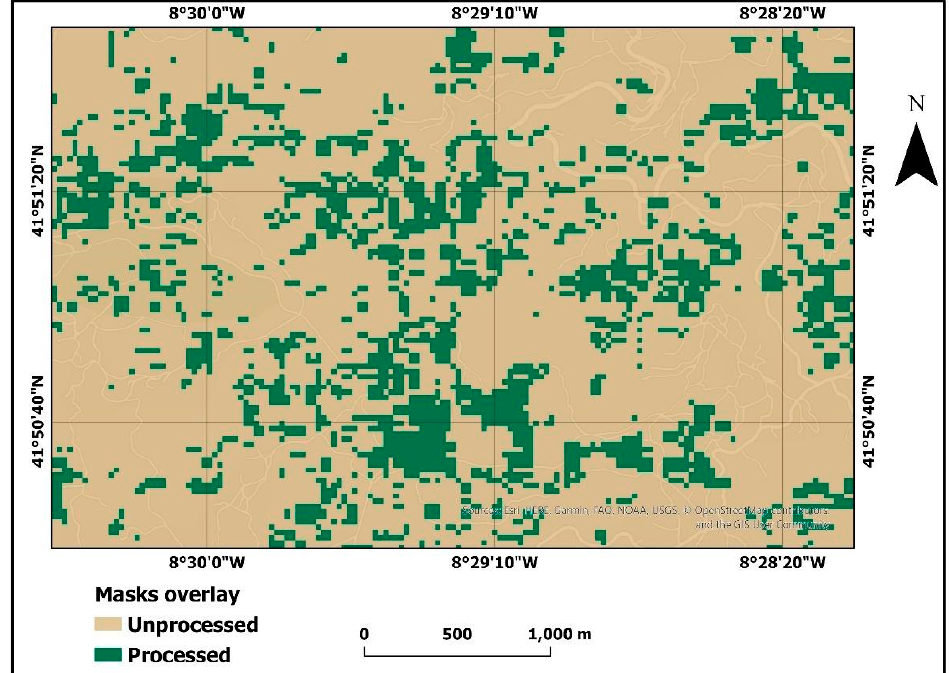
Figure 4. Resulting mask obtained by overlaying the masks for tree cover, forest loss, and local incidence angle (LIA). “Processed” pixels are characterized by tree cover higher than 90%, a local incidence angle (LIA) lower than 65°, and a forest loss of 0%.